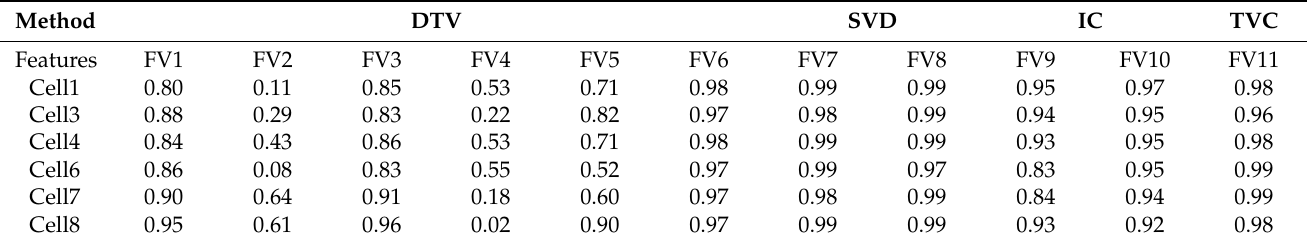
Table 4. Pearson correlation coefficients between feature variables and SOH for the Oxford